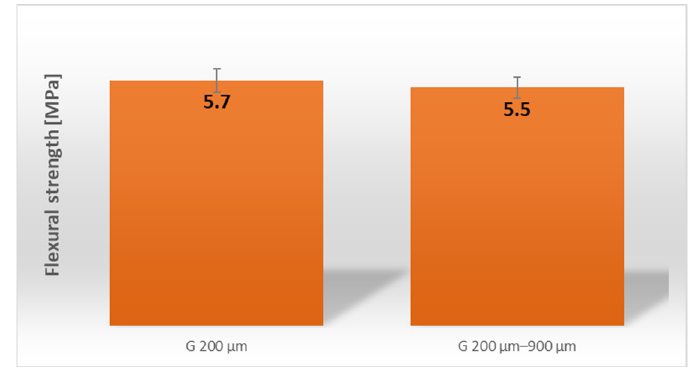
Figure 3. Results from the flexural strength test.